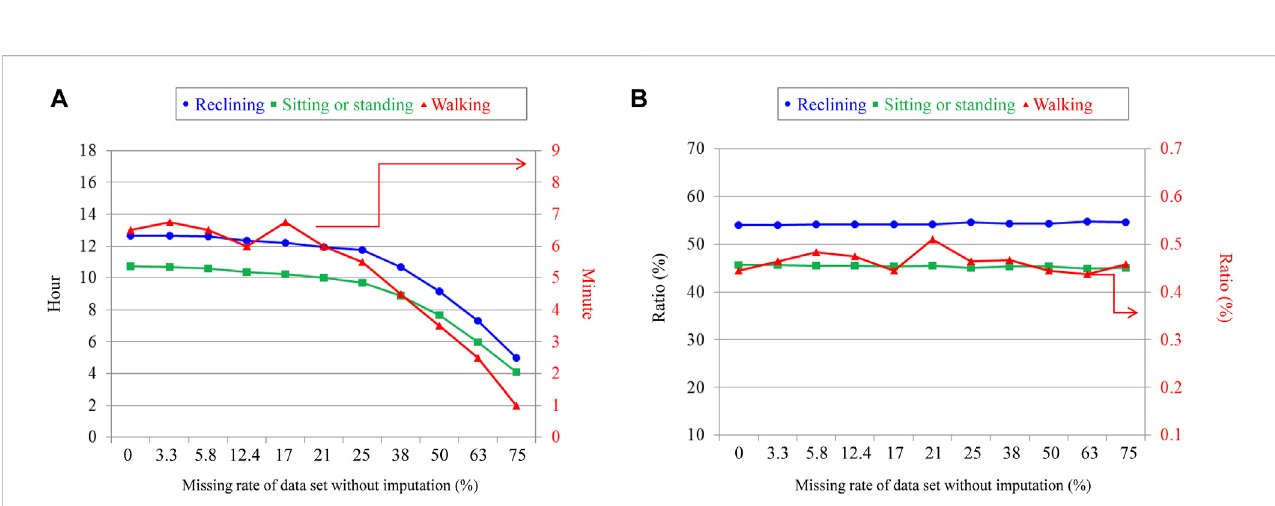
FIGURE 4 Total periods and ratios of each posture taken during 24 h with imputation. (A) Relationship between periods of each posture taken by stroke inpatients and missing data rate. (B) Relationship between the periods of each posture over the total activity periods and missing data rate. The vertical axis on the left shows the scale for reclining and sitting and standing postures. The one on the right shows the scale for